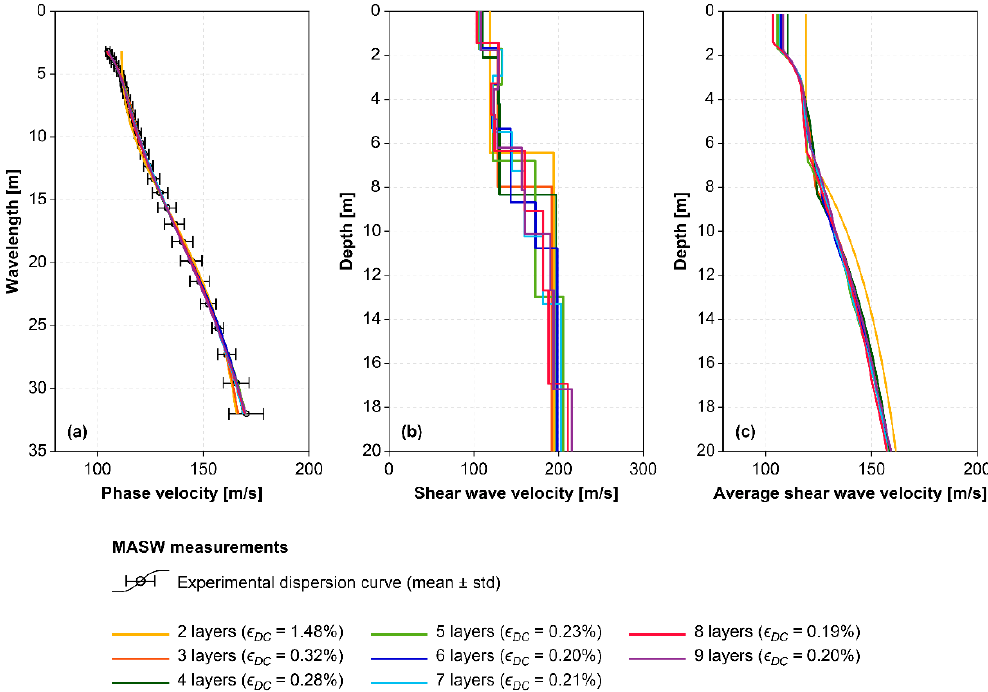
Figure 20. Results of MASW measurements conducted at the Halden research site. Comparison of inversion results obtained using different layering parameterizations consisting of two to nine layers.